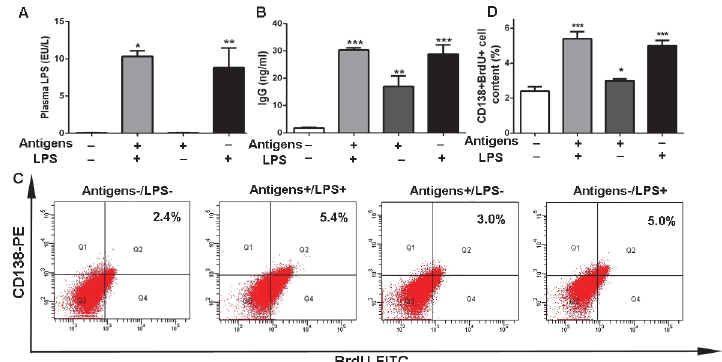
Fig 6. The diseased liver cannot dispose of antigens and endotoxins from the gut and activates the proliferation of plasma cells. (A) Plasma LPS level was measured in serum with different antigen and LPS levels (antigen-/LPS-, antigen+/LPS+, antigen+/LPS-, and antigen-/LPS+ serum). ++++(B) IgG was tested in mice immunized with antigen-/LPS-, antigen+/LPS+, antigen+/LPS-, and antigen-/LPS+ serum. (C and D) FACS analysis shows the proliferation of plasma cells (CD138+BrdU+) in antigen-/LPS-, antigen+/LPS+, antigen+/LPS-, and antigen-/LPS+ serum-challenged BALB/c mice, respectively, three FACS samples were analyzed. Antigen-/LPS-: serum from the inferior vena cava of healthy mice. Antigen+/LPS+: portal venous serum of healthy mice. Antigen+/LPS-: serum was separated from the portal venous blood of mice treated with antibiotics. Antigen-/LPS+: serum was collected from inferior vena cava blood of LPS-challenged mice. * p < 0.05, ** p < 0.01, *** p <